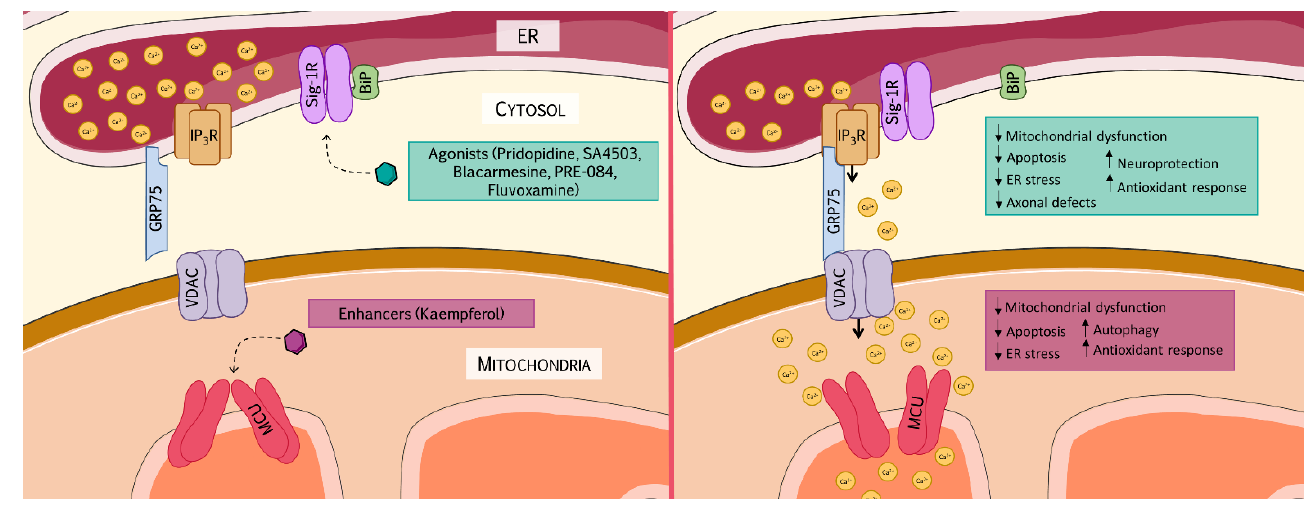
Figure 1. Schematic representation showing the effects of mitochondrial Ca 2+ uptake promoters. The ER is the main Ca 2+ storage in the cell and Ca 2+ exchange between the ER and the mitochondria requires the formation of tethers composed by proteins of both compartments. Sig-1R resides in the ER membrane, in a dormant, Ca 2+ -dependent state. Upon activation by agonists, Sig-1R dissociates from BiP/GRP78 and reallocates within the ER membrane, interacting with IP 3 R and chaperoning the protein complex that transfers Ca 2+ to the mitochondria. This complex formed by IP 3 R-GRP75-VDAC ensures a rapid Ca 2+ flux to the mitochondrial intermembrane space, which triggers MCU opening and Ca 2+ to cross the mitochondrial inner membrane. Several models of neurological disorders such as ALS, CMT and FRDA have exhibited alterations in mitochondrial Ca 2+ buffering by defective appositions between the two organelles. Both Sig-1R agonists and MCU enhancers promote Ca 2+ exchange between the ER and the mitochondria, exerting beneficial effects in different models of neurological diseases. On the one hand, Sig-1R agonists (pridopidine, SA4503, Blacarmesine, PRE-084, and fluvoxamine) have been demonstrated to exert neuroprotective effects, improving mitochondrial dysfunction, preventing cells from apoptosis, activating the antioxidant response, ameliorating ER stress, and improving axonal defects. On the other hand, the MCU enhancer, Kaempferol, has helped to improve mitochondrial dysfunction, activate the oxidative stress response, modulate autophagy, regulate ER stress, and prevent cells from apoptosis. This figure has been created using Creative Commons resources from Servier Medical Art [99]. ALS: amyotrophic lateral sclerosis; Bip/GRP78: binding immunoglobulin protein/glucose-regulated protein 78; CMT: Charcot–Marie– Tooth; ER: endoplasmic reticulum; FRDA: Friedreich’s ataxia; GRP75: glucose-regulated protein